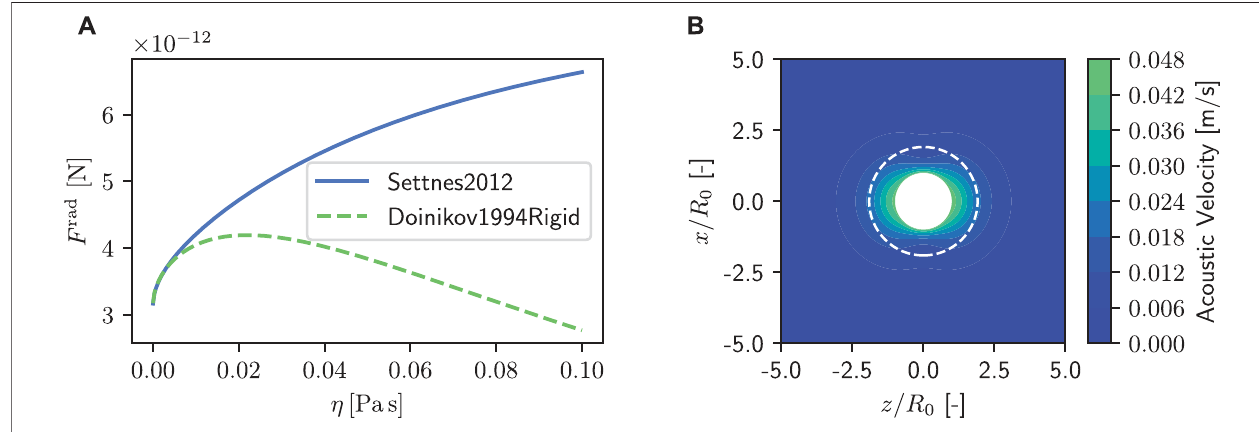
FIGURE 5 | Copper particle in a viscous oil placed half way between the velocity node and the velocity anti-node of a f = 0.5 MHz standing wave fi eld. (A) ComparisonoftheARFinthemodelfromDoinikov[8]andfromSettnesandBruus[14]. (B) Velocityamplitudesofthescatteredacoustic fi eldaroundtheparticlefor η oil = 30 mPa s plotted using the model by Doinikov. The dotted line represents the boundary layer thickness δ